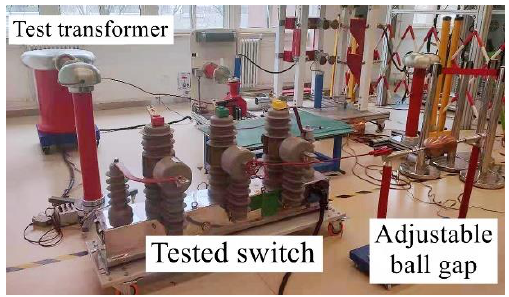
Figure 6. Field wiring diagram.